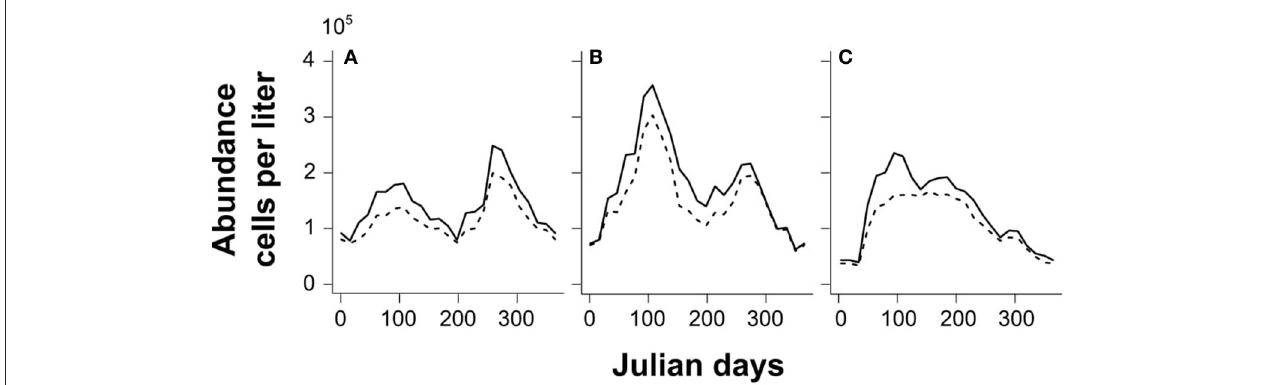
FIGURE 8 | Mean seasonal abundance (10 5 cells per liter) based on in-situ CPR counts between 1998 and 2010 for the labeled assemblages (solid lines) and their indicator species (dashed lines): (A) Thalassionema nitzschoides assemblage; (B) Thalassiosira spp. assemblage ; and (C) Rhizosolenia imbricata assemblage.